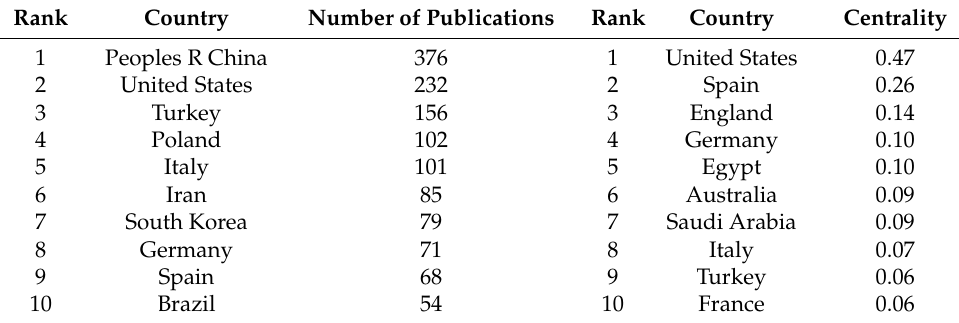
Figure 3. The knowledge mapping of counties/regions in irisin research. Here, each node represents a country, and the size of the node is proportional to the number of publications. The connection represents the cooperative relationship between countries. The thickness of the connection between two nodes represents the intensity of cooperation. The number of connections between nodes represents the degree of cooperation, and the outermost purple of the node represents the centrality. The wider the purple width is, the higher the centrality is, indicating the greater the contribution of the node in the research field. Table 1. Spatial distribution information of irisin research.